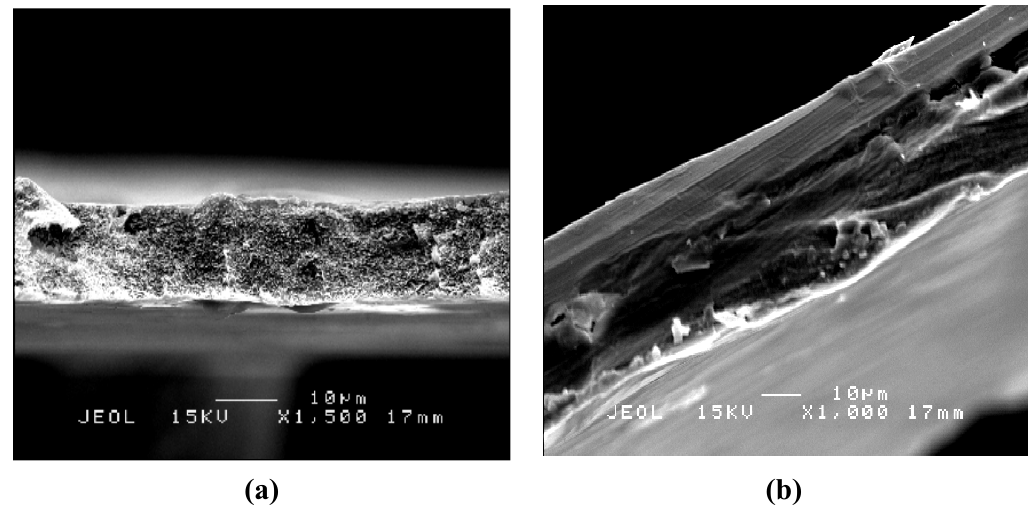
Figure 4. Cross section of ( a ) CA-MB-MIP membrane and ( b ) CA membrane.